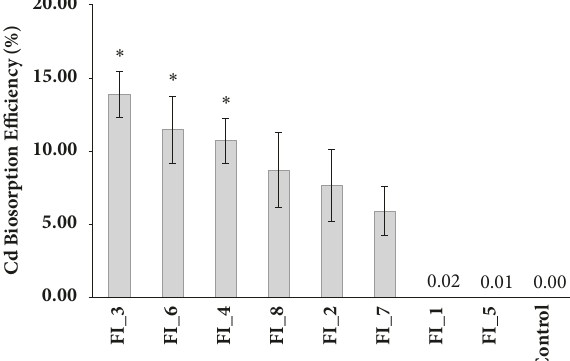
Figure 2: Cd biosorption efficiency (mean % ± SE; n=3) of the fungal isolates after five days of biosorption assay; ∗ (p ≤ 0.05) Tukey’s HSD; FI=fungal